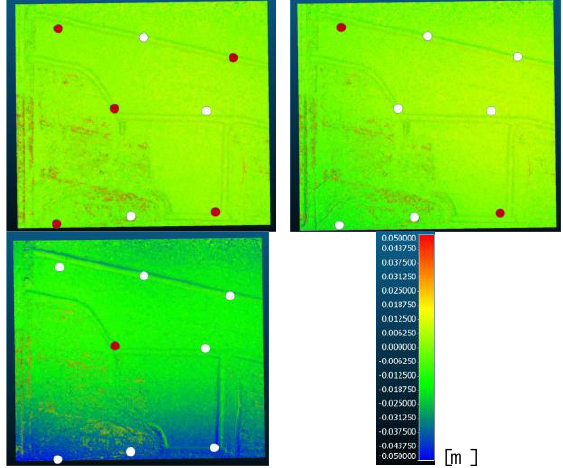
Figure 9. Comparison of point clouds from Metashape; top left: 5 GCPs; top right: 2 GCPs; bottom left: 1